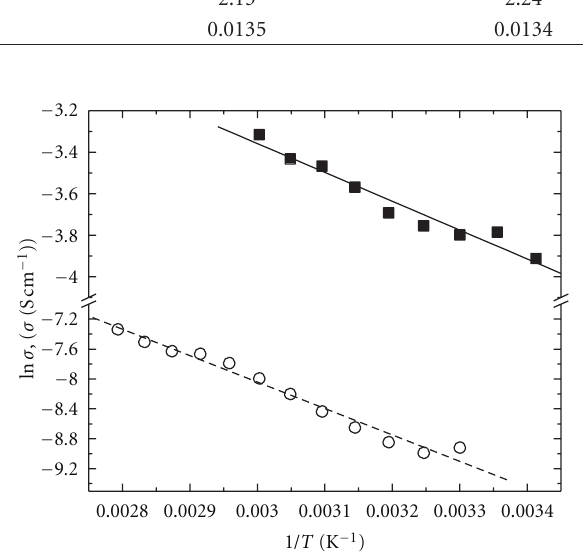
Figure 11: Arrhenius plot showing the temperature dependence of the P5FNDIHS (squares) and C5FNDIHS (circles)